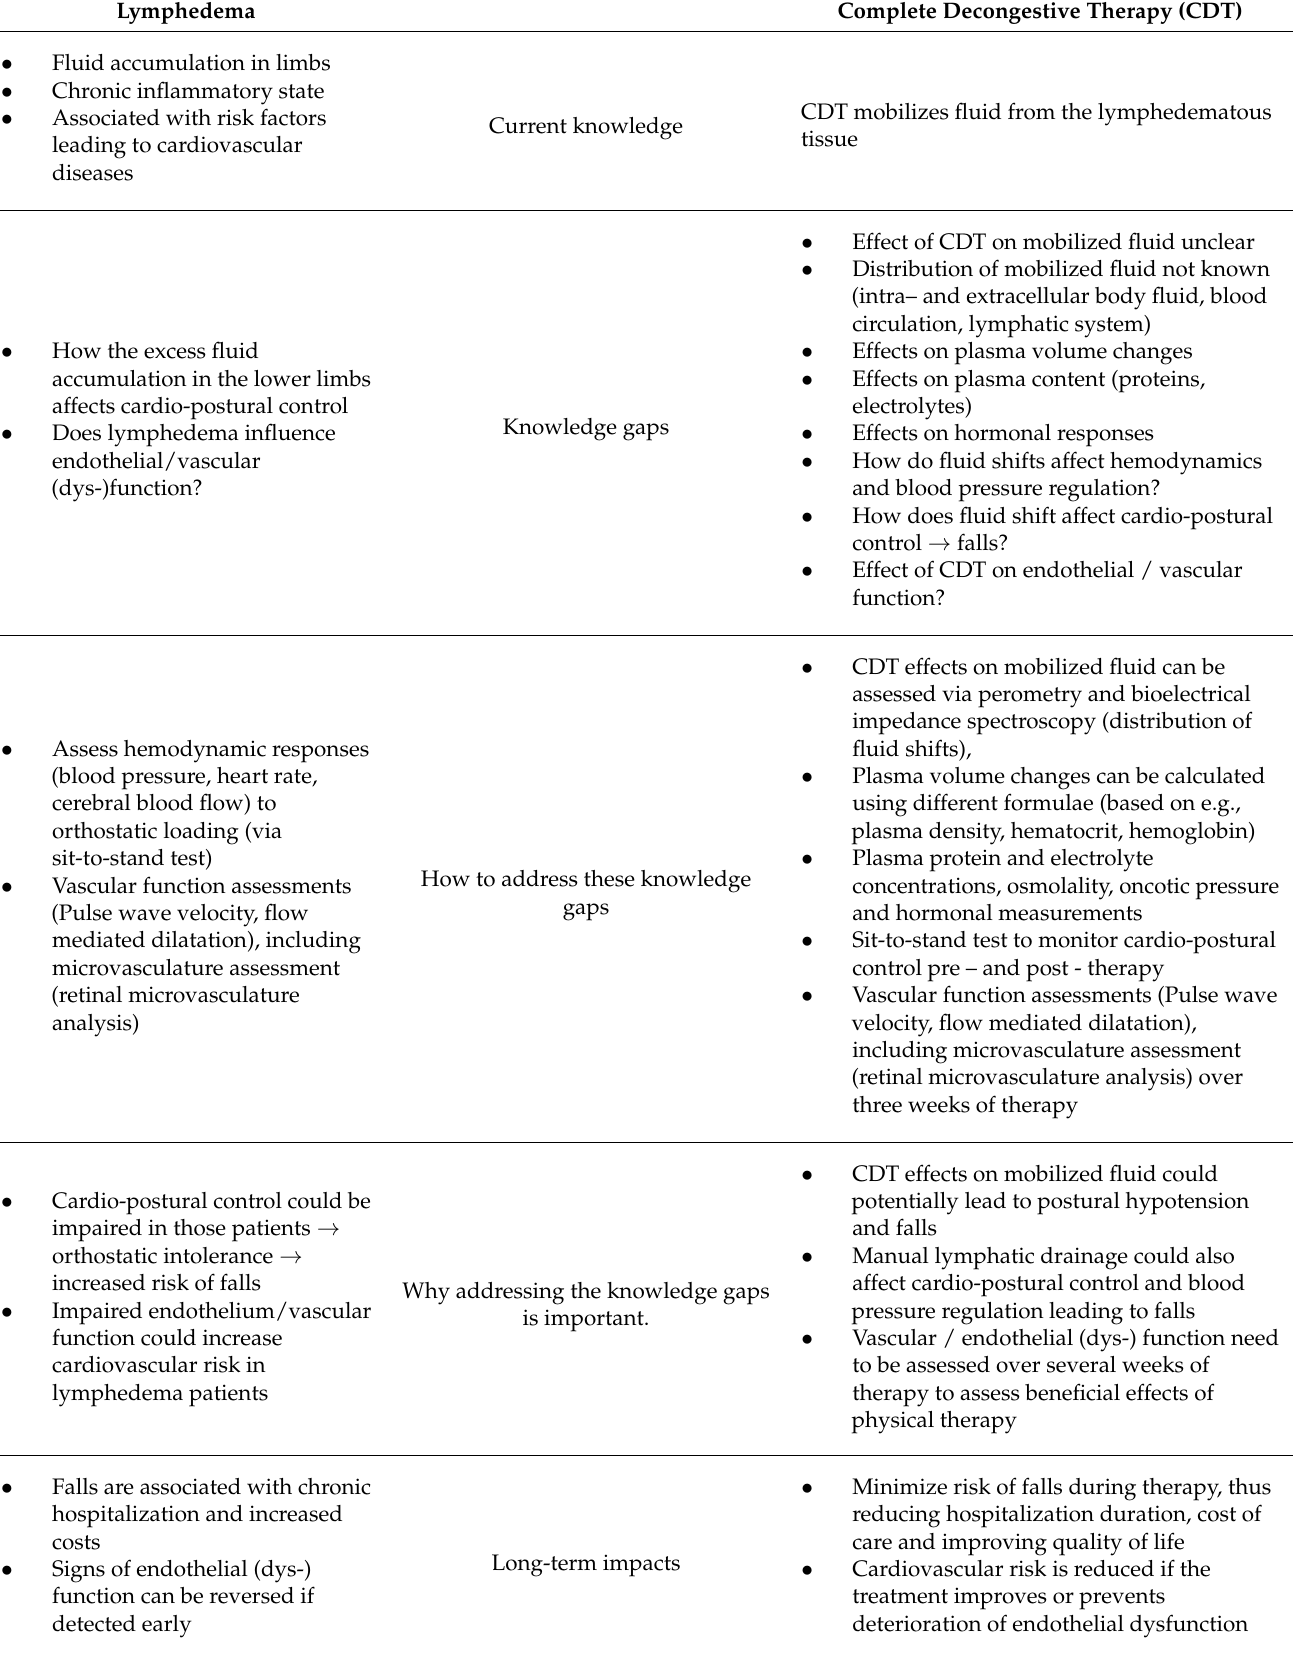
Table 2. Overview of lymphedema and lymphedema therapy, current knowledge, knowledge gaps, and how those can potentially be